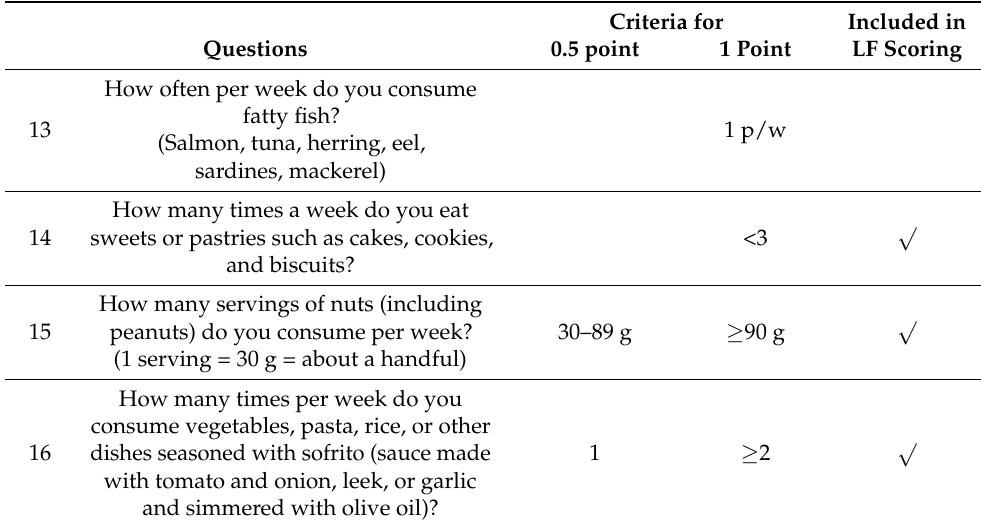
Criteria for Included in